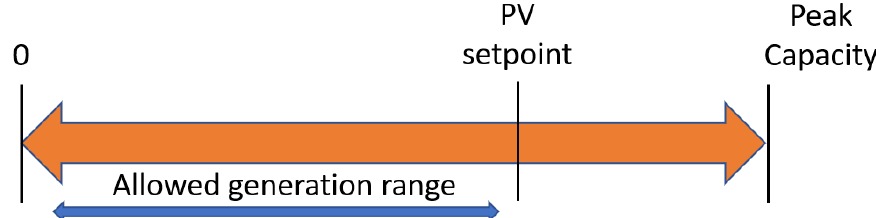
Figure 4. Definition of the PV maximum injection setpoint compared to its total capacity.